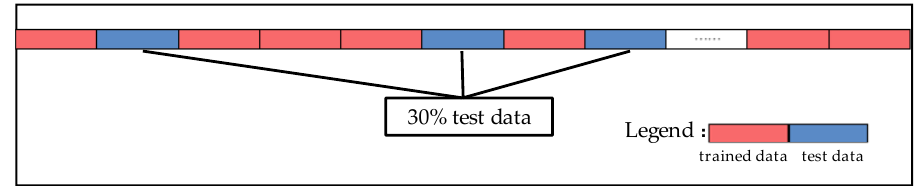
Figure 10. Splitting of a data set showing the 70% training data and the 30% testing data set.